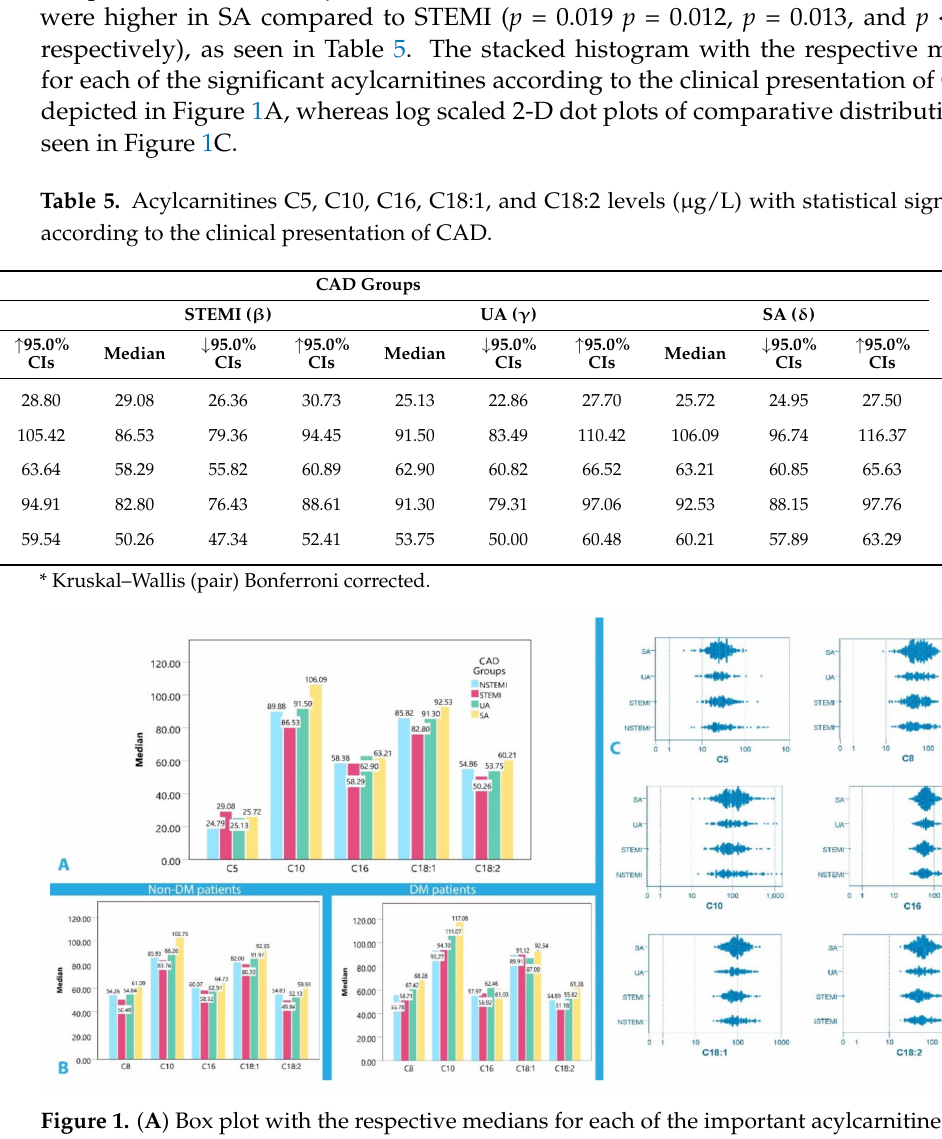
Figure 1. ( A ) Box plot with the respective medians for each of the important acylcarnitines for the CAD groups, ( B ) Box plot with the respective medians for each of the important acylcarnitines for the CAD groups in DM and non-DM patients, ( C ) ACS vs. CCS 2-D log scaled plots for C5, C8, C10, C16, C18:1, and C18:2 level